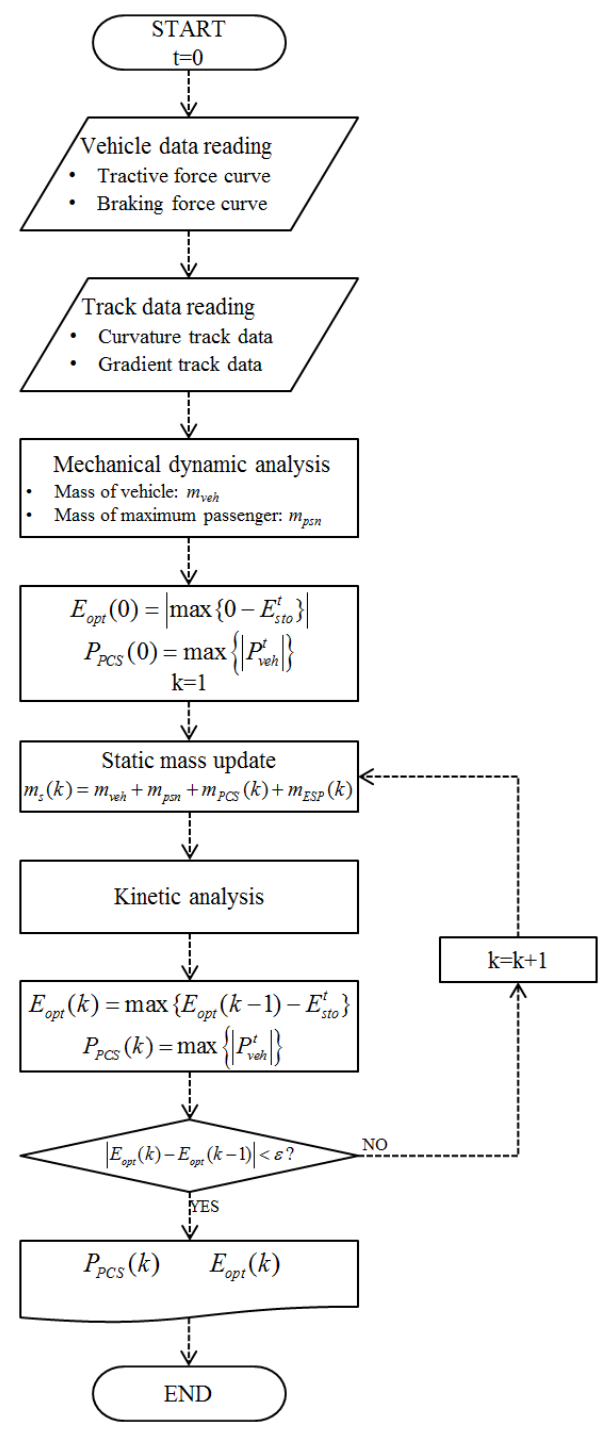
Figure 4. Flowchart to find optimal power and storage capacity.